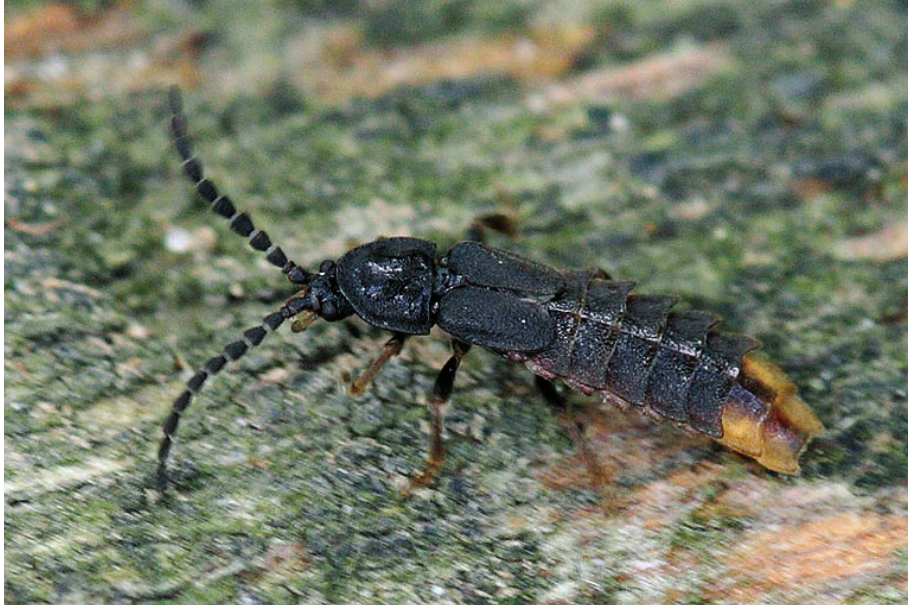
Figure 1. An adult male specimen of Phosphaenus hemipterus (photographed in Switzerland). Note the broad antennae, small eyes, lampyrid-shaped pronotum, and the shortened elytra exposing seven abdomi- nal segments, the last two bearing bioluminescent organs. Photo credit: Urs